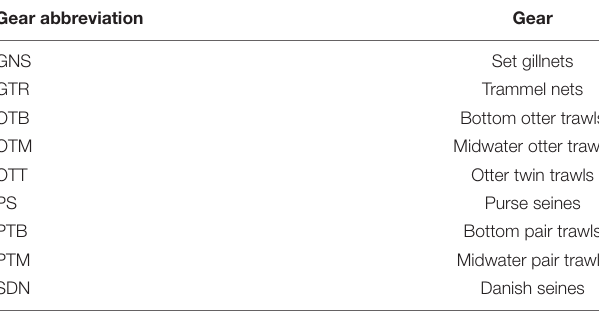
TABLE 1 | Fishing gear included in the study and their ICES